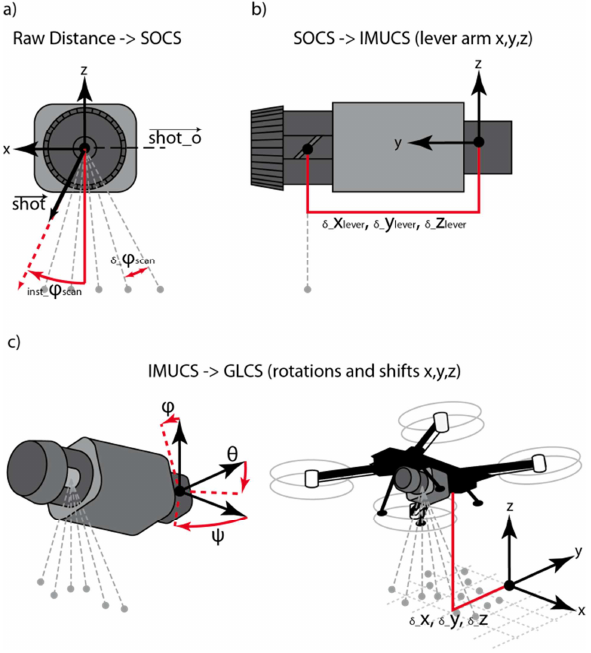
Figure 2. Different transformation components for the transformation of from SOCS to GLCS. a)